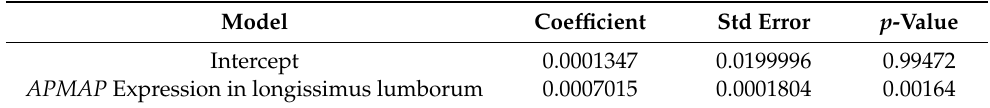
Table 2. APMAP expression affected IMF in Rex rabbits (regression coefficients, standard errors, and probability